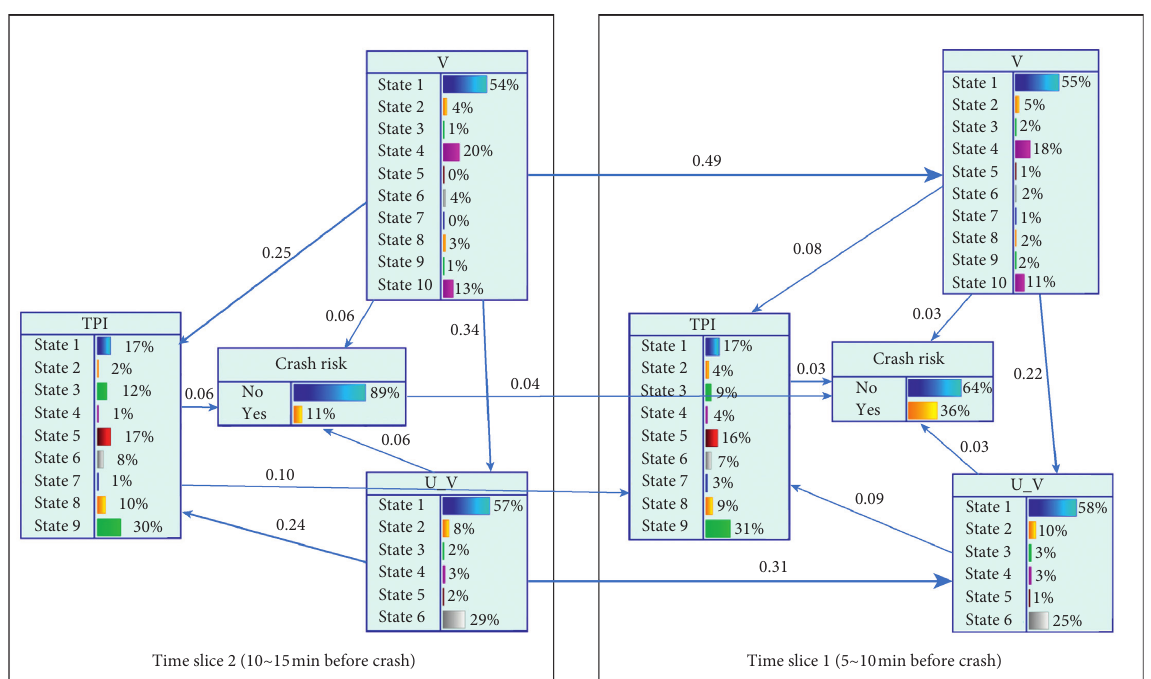
Figure 11: Results of strength of influences